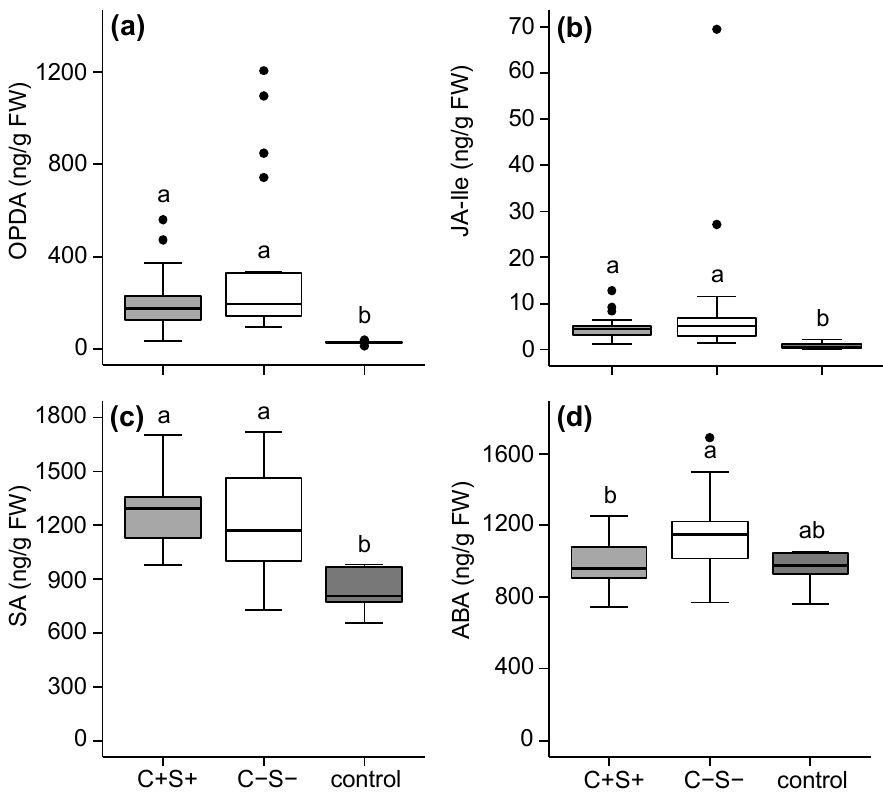
Figure 4. Phytohormone amounts in tomato ( S. lycopersicum ) leaflets after seven days of infestation with the spider mite T. urticae Santpoort-2 strain which did (+) or did not ( − ) contain the bacteria Cardinium (C) and Spiroplasma (S). Control plants were not infested. Phytohormones for which we assayed include ( a ) OPDA; ( b ) JA-Ile; ( c ) SA; and ( d ) ABA. Boxes span the 25–75 percentiles, horizontal lines in the boxes represent medians, whiskers span 1.5× IQR, dots represent data points outside of this range. Different letters above the boxes indicate significant differences at a level of p ≤ 0.05, after applying linear mixed models followed by Tukey multiple comparisons with Holm adjustment. Phytohormone amounts are presented as nanogram per gram fresh leaf weight (ng·g − 1 ·FW).